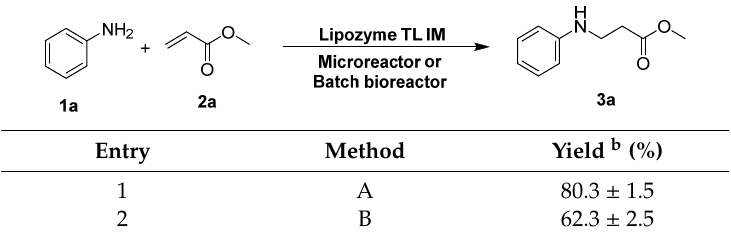
Table 1. Enzymatic Michael addition of aniline in the continuous-flow reactor or batch bioreactor. a